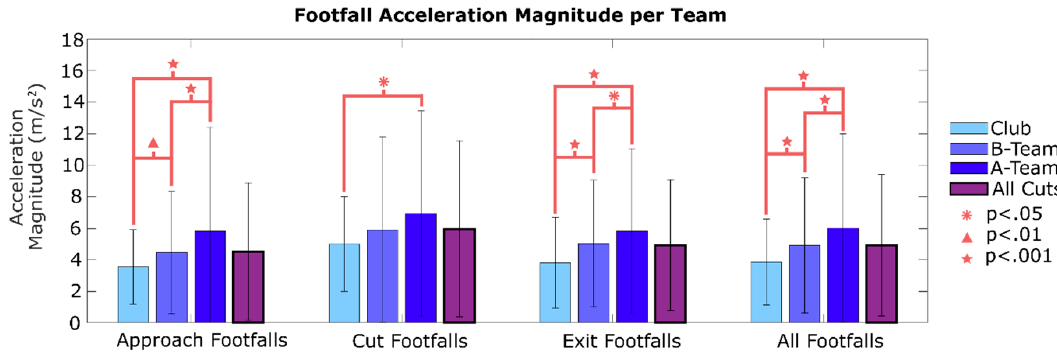
Figure 9. Mean footfall acceleration magnitude for each team, and for all cuts collectively. Mean values for each phase of the cut, in addition to all cutting footfalls, are shown. Cuts from the A-team tend to have larger footfall acceleration vectors.